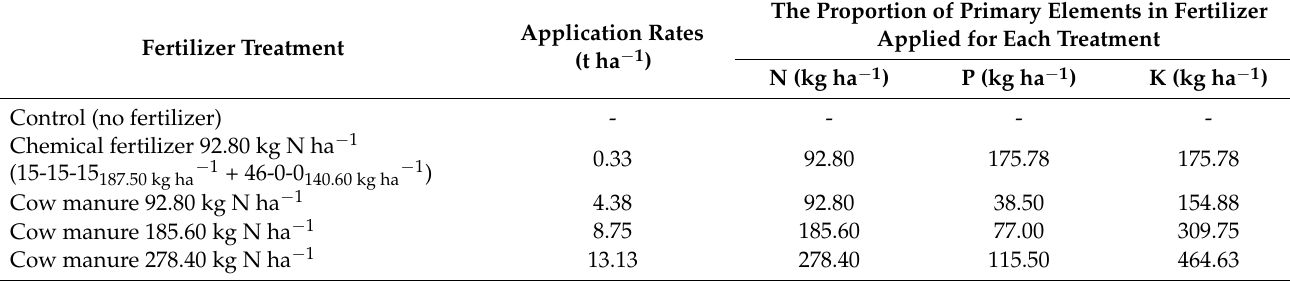
Table 1. Background plant nutrient contents in various fertilizers applied for each different shading